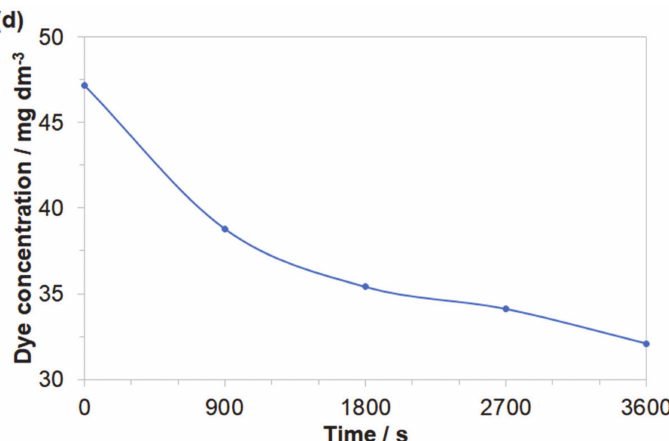
Figure 8. Representation of the three segments of dye electrooxidation process on the surface of Al alloy anode in Na 2 SO 4 -based Acid Mixture solution (at the concentration of 50 mg dm − 3 ): ( a ) Evolution of decolourization process recorded for the wavelength of 500 nm; ( b ) Progress of aromatic ring degradation recorded for the wavelength of 280 nm; ( c ) Evolution of mineralization process recorded for the wavelength of 240 nm; ( d ) Quantitative dye assay after sedimentation process for the wavelength of 500 nm.